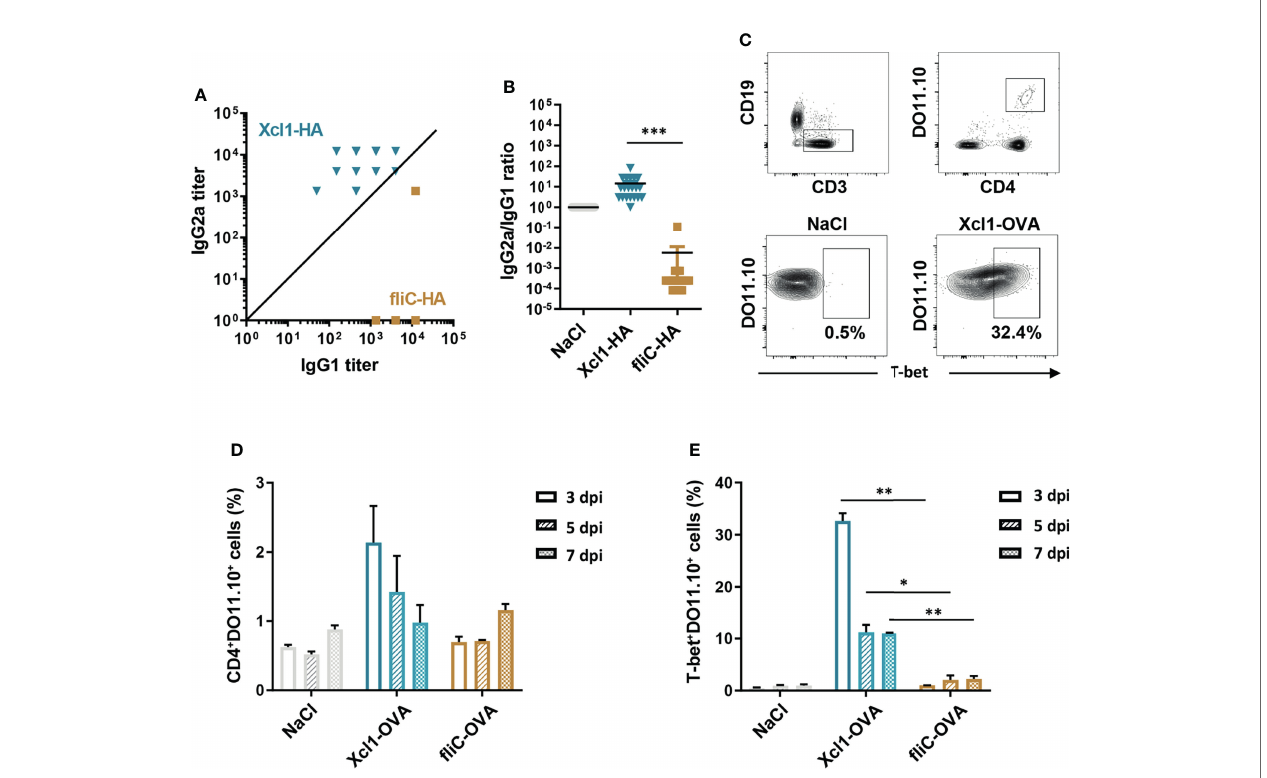
FIGURE 1 | DNA immunization with Xcl1-HA induces rapid Th1-associated immune responses. (A) IgG1 and IgG2a anti-HA antibodies in sera from BALB/C mice obtained 2 weeks after a single i.d. DNA immunization/electroporation with 25 m g plasmid encoding Xcl1-HA or fl iC-HA. (B) IgG2a/IgG1 ratios in single mice presented in (A) . (C – E) 1 × 10 6 naïve DO11.10 cells were transferred to BALB/c mice that were subsequently immunized with 25 m g plasmid encoding Xcl1-OVA or fl iC-OVA. Inguinal LNs were harvested 3, 5, or 7 days after vaccination. (C) Gating strategy for identi fi cation of CD4 + DO11.10 + and expression of the transcription factor T-bet. (D) Percentage of CD4 + DO11.10 + cells and (E) T-bet + DO11.10 cells elicited by immunization. Data shown are either pooled from 2 independent experiments (A, B) , or representative of two independent experiments (C – E) , with 20 (A, B) , or 3 (C – E) mice per group. Statistical analysis was performed using the non-parametric t-test (B) or one-way ANOVA with Tukey ’ s multiple-comparison test comparing Xcl1-OVA and fl iC-OVA for the different timepoints (D, E) . *p < 0.05, **p < 0.01, ***p <